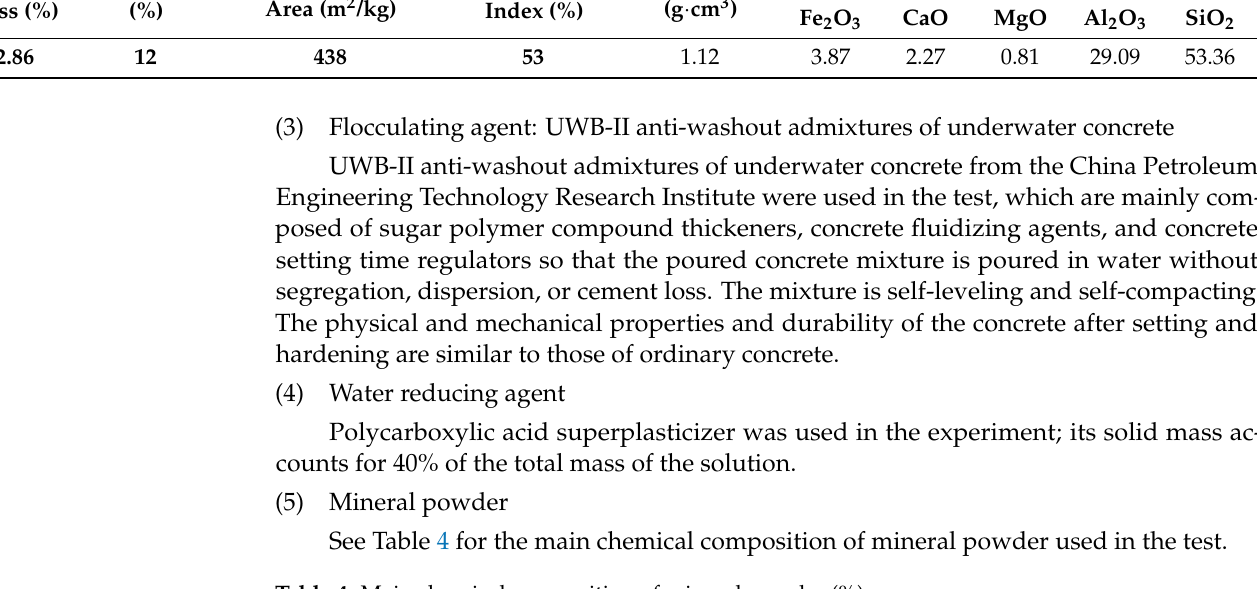
Table 4. Main chemical composition of mineral powder